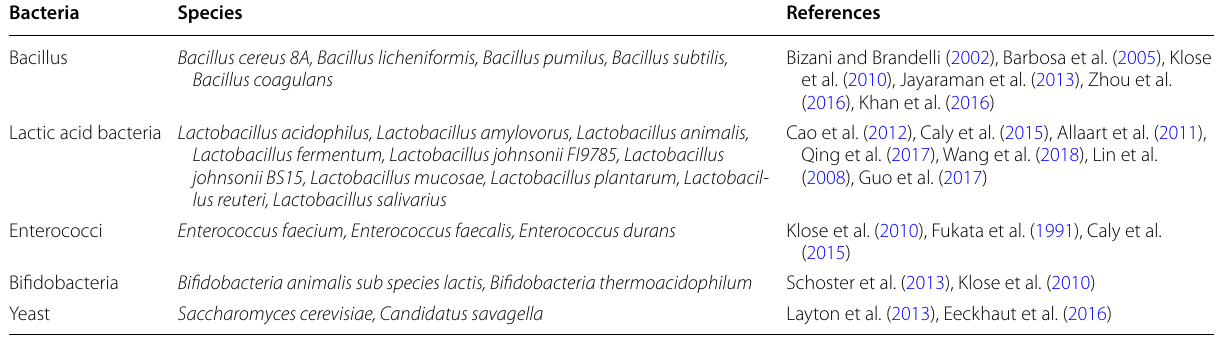
Table 1 Different microorganisms used as probiotics for the prevention of subclinical necrotic enteritis (SNE)